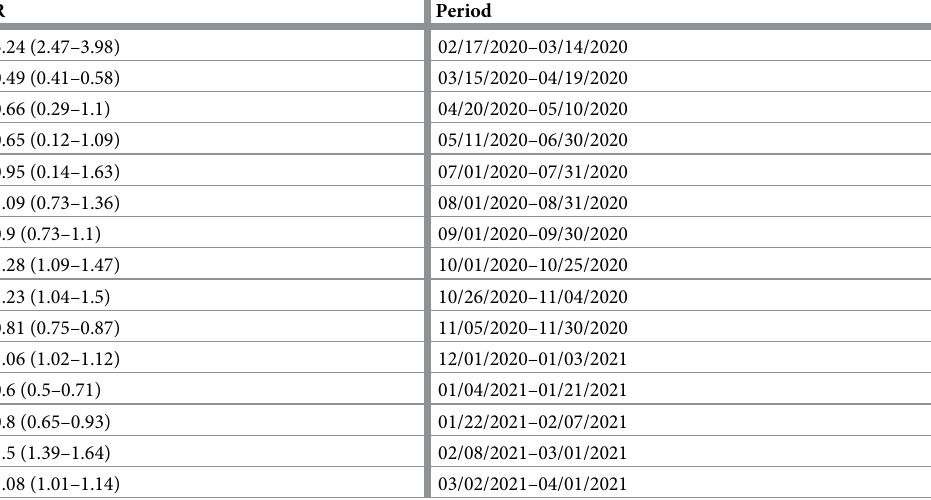
Table 2. Estimated national effective reproduction numbers (mean and 95% CI). Dates are provided as mm/dd/ yyyy.